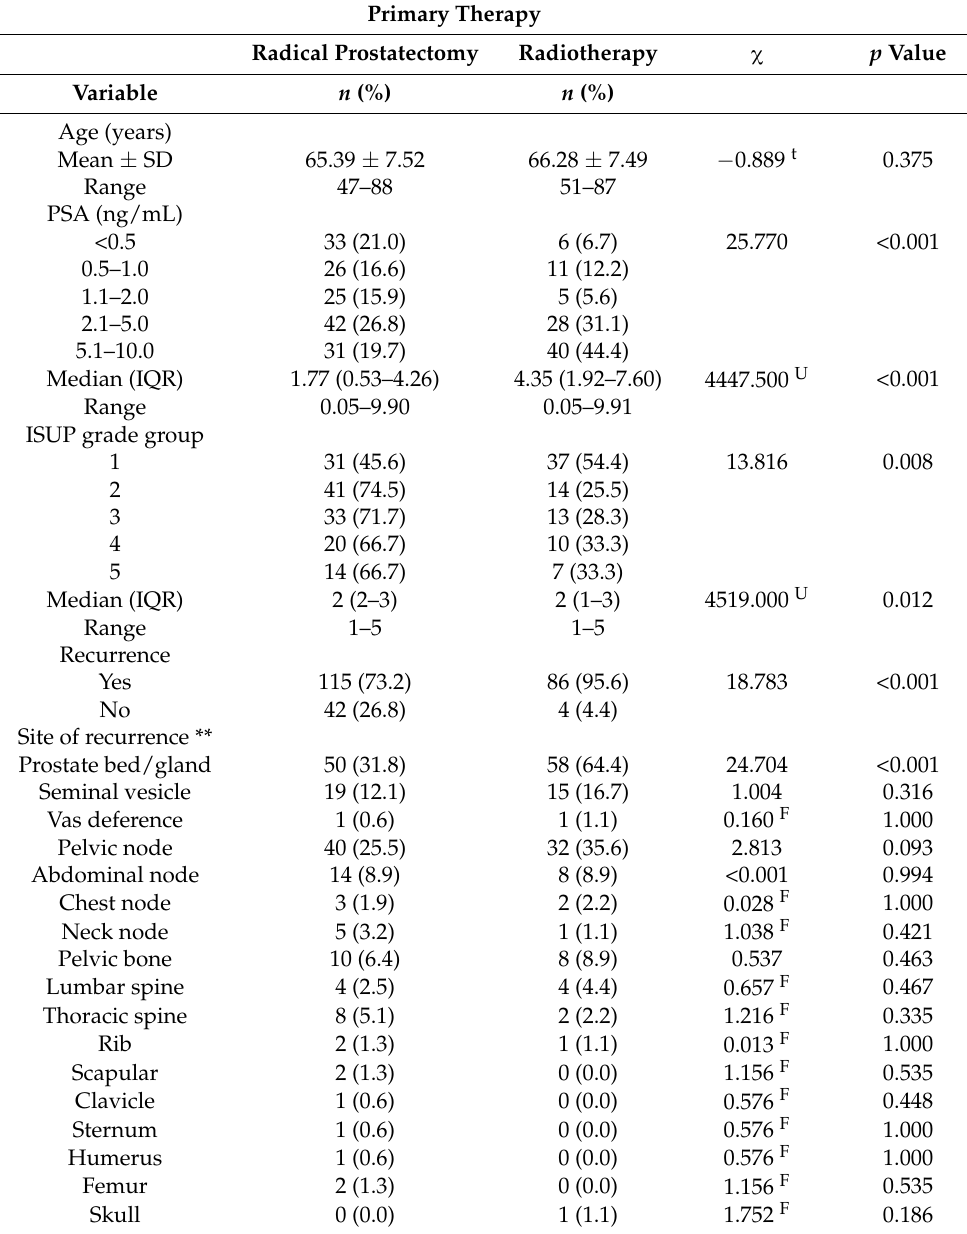
Table 4. Comparison of patients stratified according to the type of primary radical